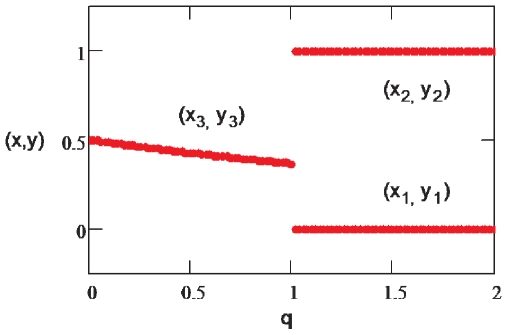
The bifurcation of the system for the bifurcation parameter q = c/b.Values are as follows: a = f = 1,d = b = 0.5 and . At the critical point q = 1 when c, which is proportional to cross inhibition, becomes larger than b, the system bifurcates from one stable (x3, y3) two to stable steady states (x1, y1) and (x2, y2) (solid lines).